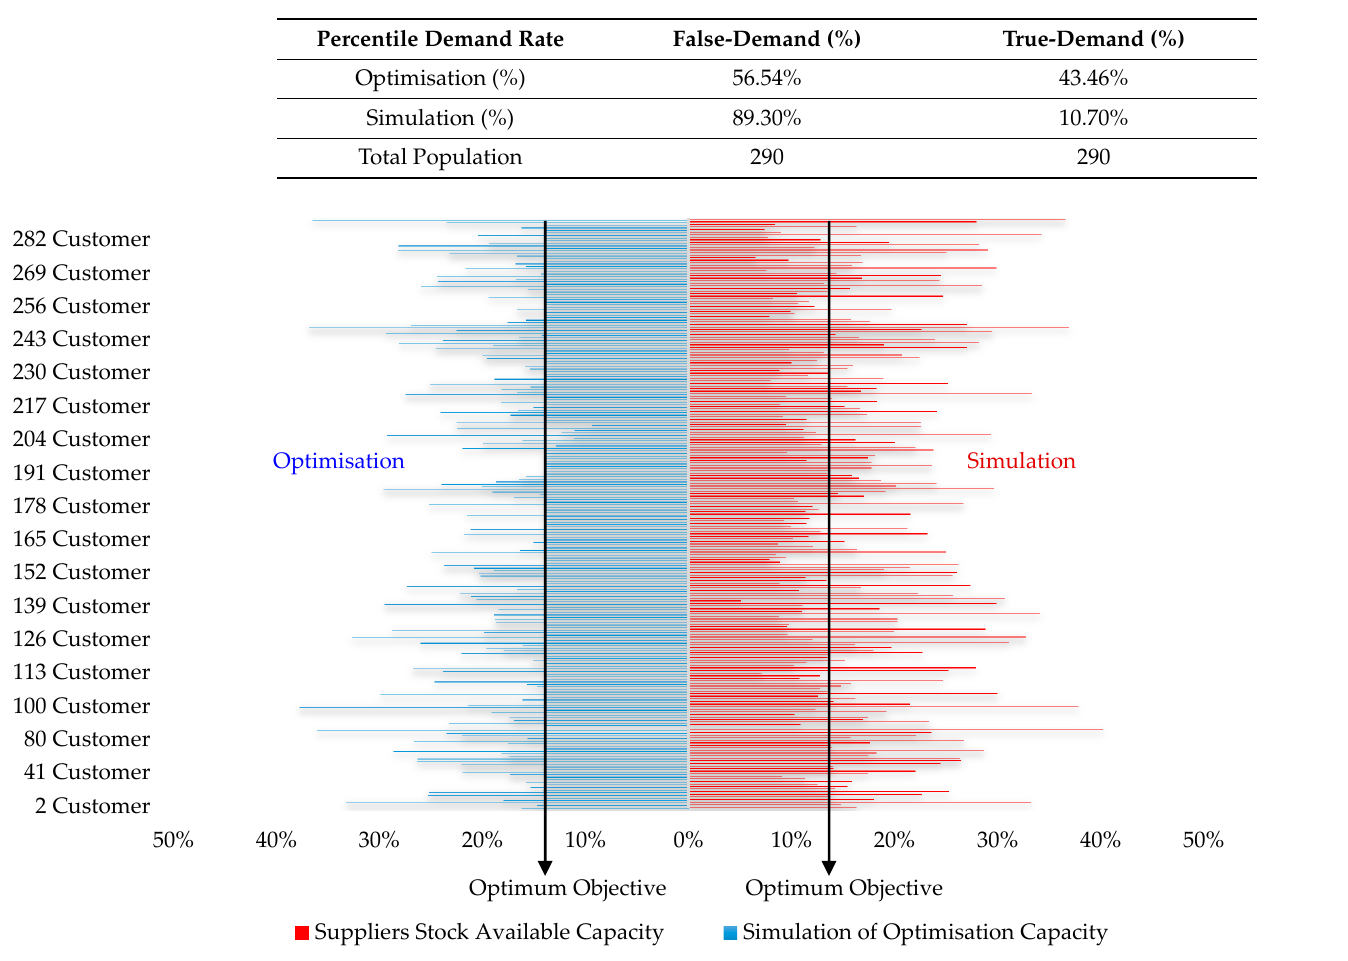
Figure 13. Tornado Diagram of Simulation and Optimisation Results.